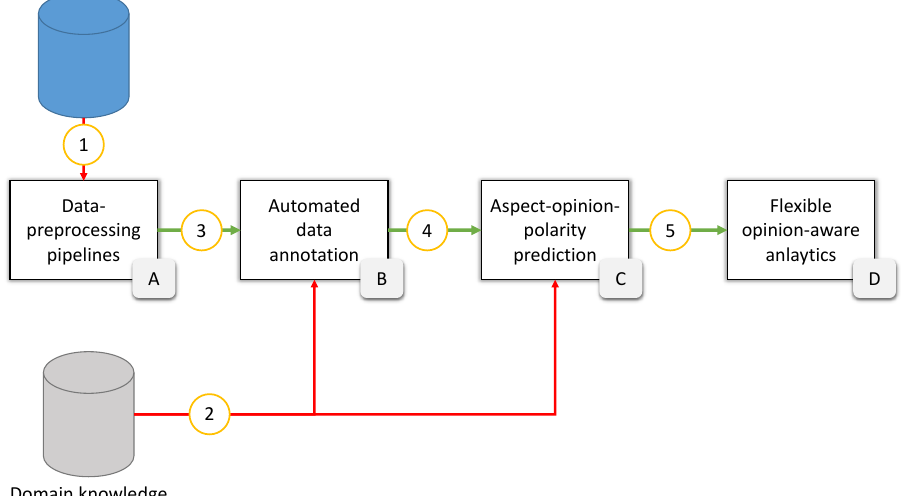
Figure 2. The research design of the proposed graph-based opinion mining and analysis